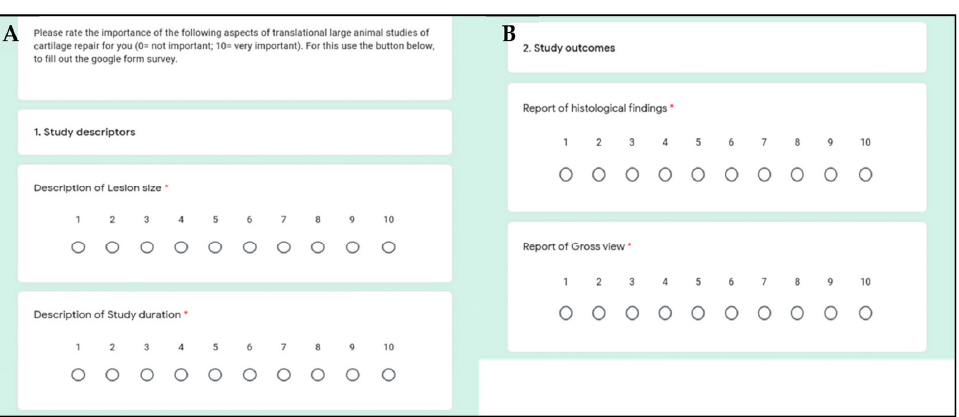
Table 1. List of 24 major aspects defined by the guidance documents.